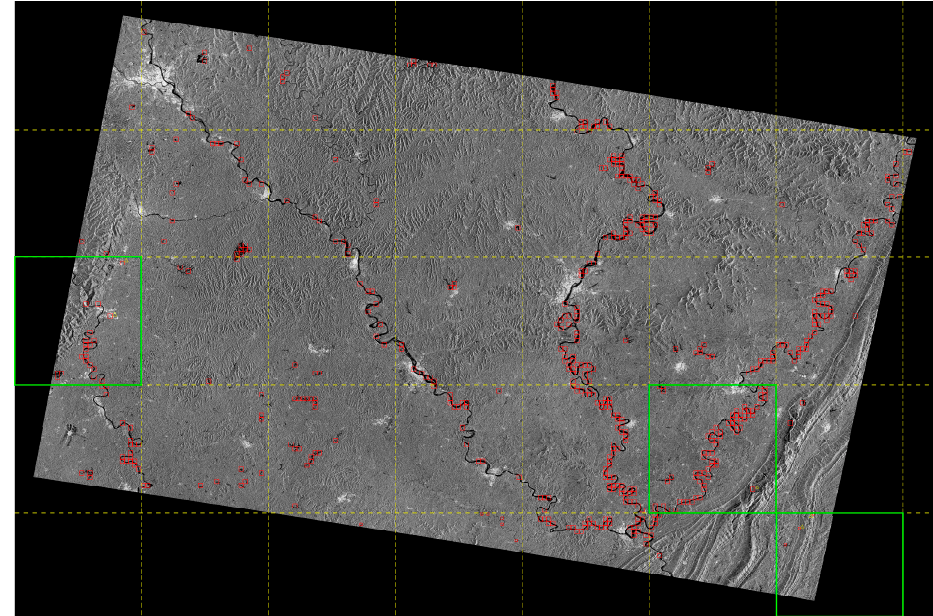
Figure 6. Sentinel-1 VV polarized data of the study area (15 July 2018) with the target bimodal regions (in red boxes) using the BC parameter, where the false alarms are notated by the yellow triangle beside them.